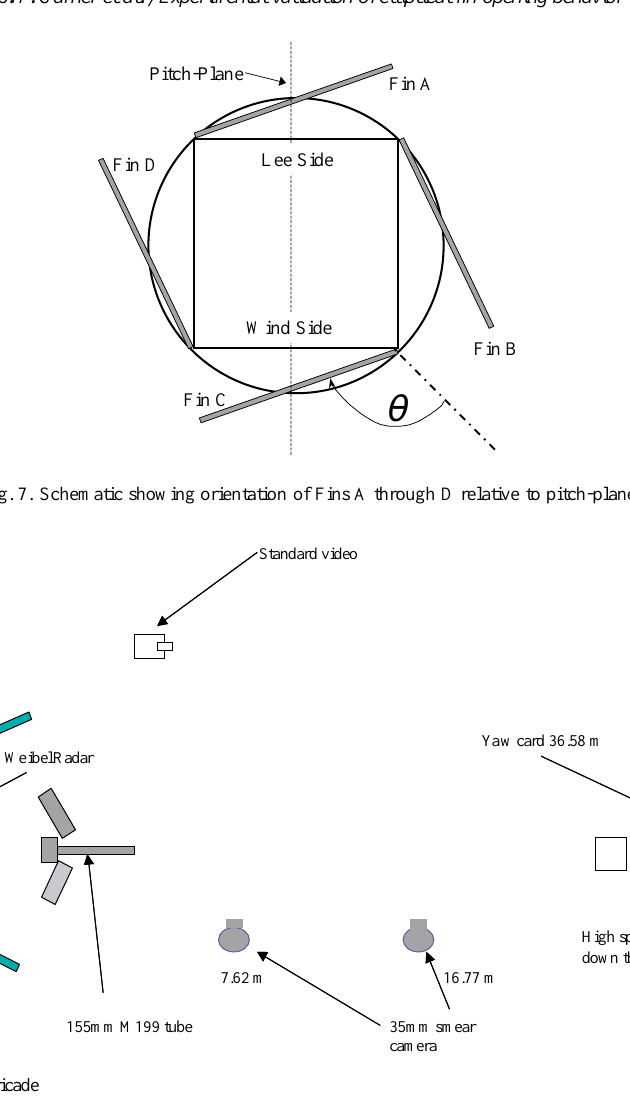
Fig. 8. Schematic showing orientation of test